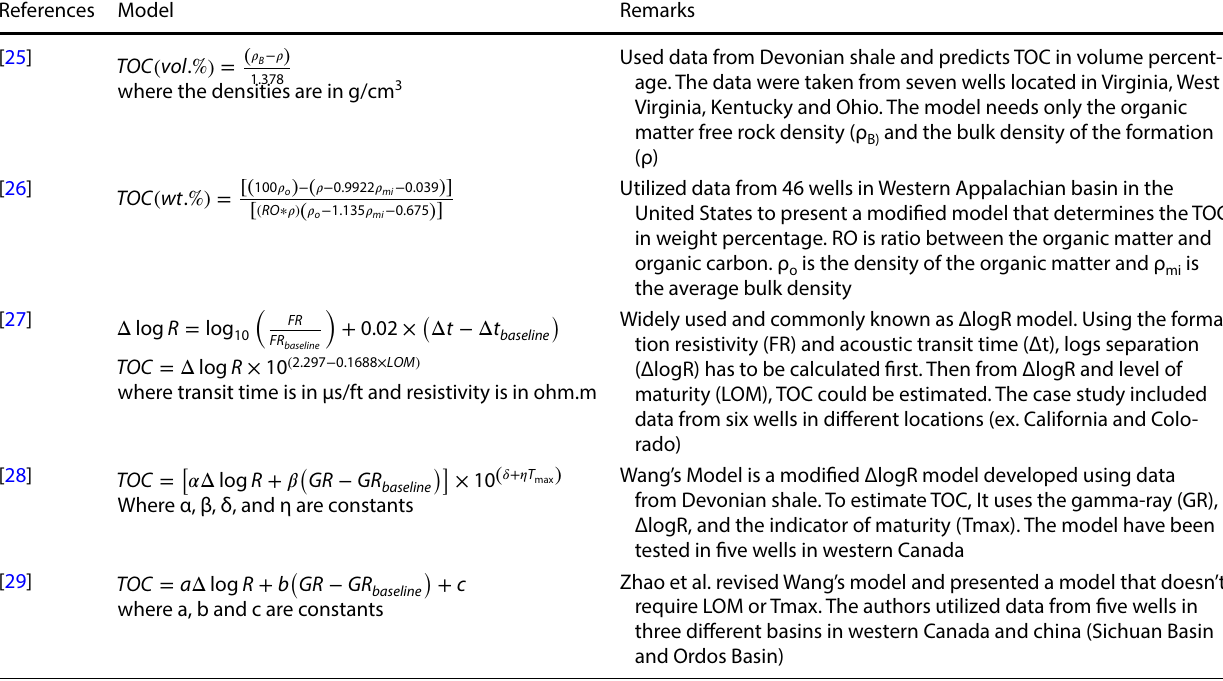
Table 1 Different correlations of